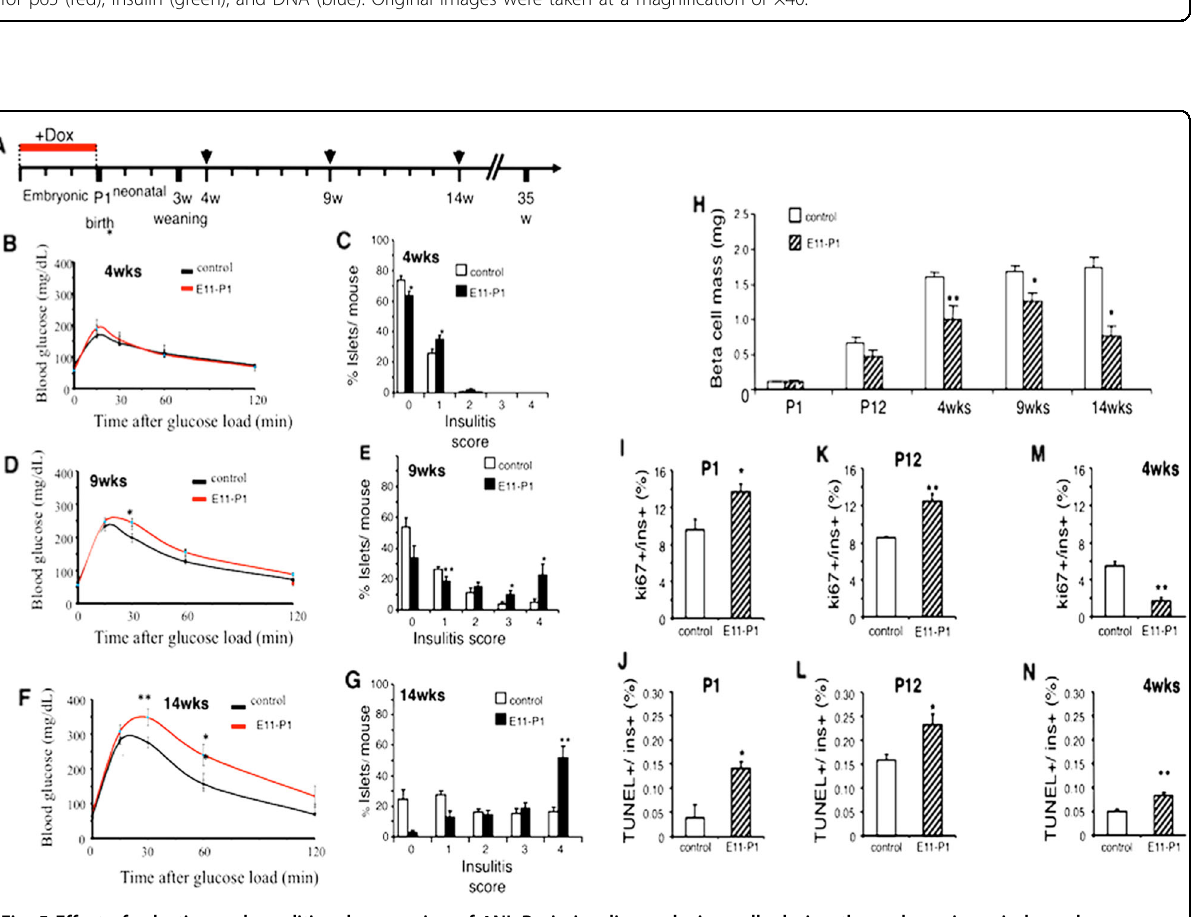
Fig. 5 Effect of selective and conditional expression of Δ NI κ B α in insulin-producing cells during the embryonic period on glucose tolerance, the degree of insulitis, β -cell mass (BCM), β -cell proliferation, and apoptosis in NOD/ToI β mice. A Experimental design: NOD/ToI β or NOD/LtJ female mice were exposed to Dox during the fetal period until birth (E11 – P1). IPGTT was performed at 4 ( B ), 9 ( D ), or 14 (F ) weeks of age. After an overnight fast, mice were injected with 2 g/kg D-glucose and blood samples were collected at 0, 15, 30, 60, and 120 mins post-loading, and glucose levels were measured. The results are presented as the mean ± SEM of data pooled from untreated controls (black lines, n = 10 – 16), Dox- treated E11 – P1 (red lines, n = 12 – 13). * P < 0.05 vs control. C , E , G Insulitis scores calculated for 4, 9, and 14 weeks of age: C control, (487 islets, n = 5), E11 – P1 (436 islets, n = 5) at 4 weeks; at 9 weeks ( E ): control (249 islets, n = 4), E11 – P1 (457 islets, n = 5); and at 14 weeks ( G ): control (336 islets, n = 5), E11 – P1 (169 islets, n = 6). Values are mean ± SEM. * P < 0.04, ** P < 0.009 vs control. H BCM was determined and is presented in milligrams: mice were sacri fi ced on P1: n = 3; P12: n = 4; 4 weeks: n = 3 – 5; 9 weeks: n = 3 – 5 and 14 weeks: n = 3 – 4): controls (empty bars) or Dox-treated (hatched bars). Values are mean ± SEM. * P < 0.05, ** P < 0.01 vs control. I , K , M β -cell proliferation was assessed by co-staining for Ki67, insulin, and calculated as a percent of Ki67-positive nuclei in insulin-positive cells out of the total number of insulin-positive cells per mouse. I P1 ( n = 4 – 5, ~4550 β -cells); K P12 ( n = 4, ~7550 β -cells); M 4 weeks ( n = 3 – 4, ~8400 β -cells). J , L , N β -cell apoptosis was assessed using TUNEL assay and co-staining for insulin and calculated as a percent of TUNEL-positive nuclei in insulin-positive cells out of the total number of insulin-positive cells per mouse. J P1 ( n = 4 – 5, ~4600 β -cells); L P12 ( n = 4, ~9750 β -cells); N 4 weeks ( n = 3 – 4, ~16,400 β -cells). * P <